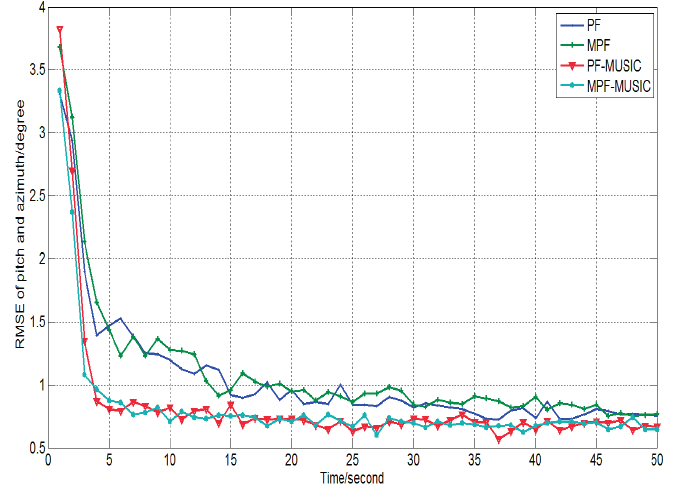
Figure 1. The RMSEs of the dynamic DOA tracking for the PF and the corresponding modified algorithms in different time.